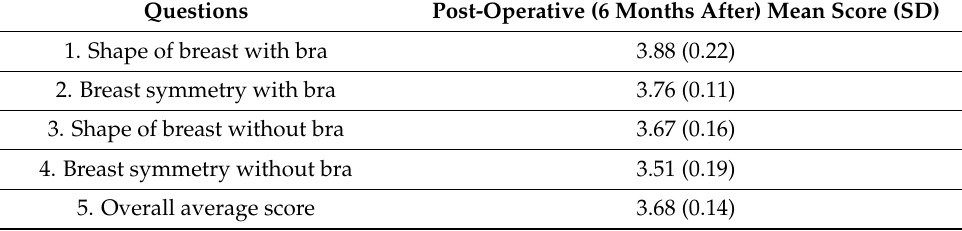
Table 2. Patient self-assessment evaluation 6 months after breast